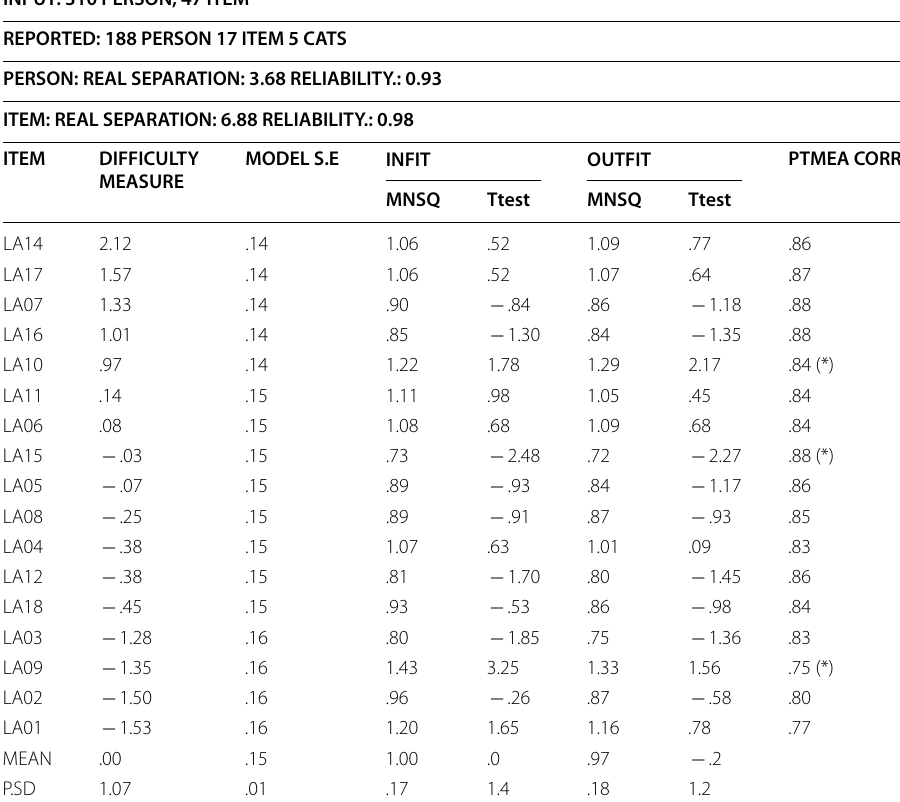
Table 4 Dimension LA: Item difficulties, standard errors, Infit, Outfit, T-test and correlations, estimated from final